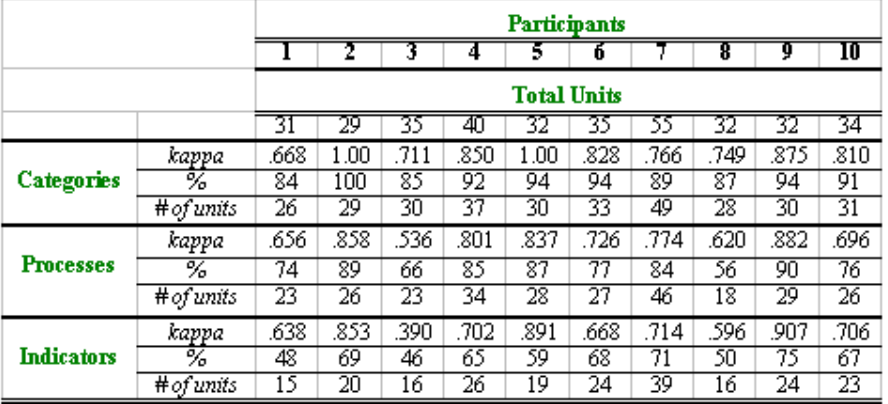
Table 3. Summary of Differences in Agreement across